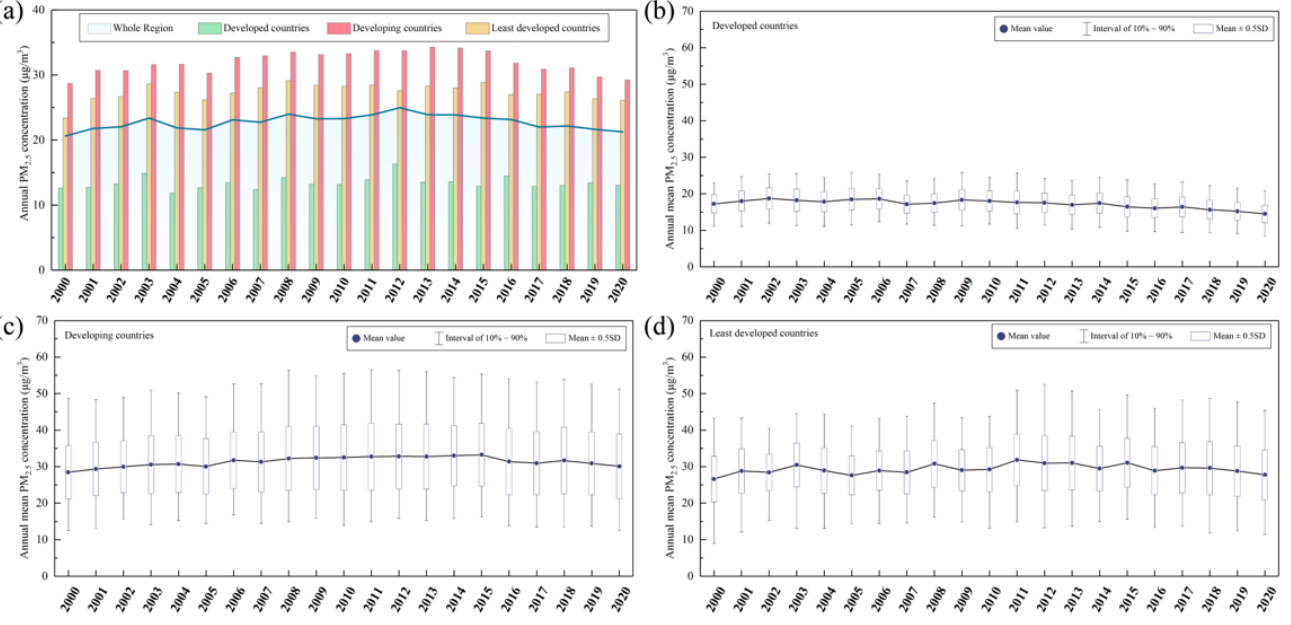
Figure 3. The temporal trends of ( a ) annual mean PM 2.5 concentrations in the whole region, distribution of city-level PM 2.5 concentrations in ( b ) developed countries, ( c ) developing countries, ( d ) least developed countries.